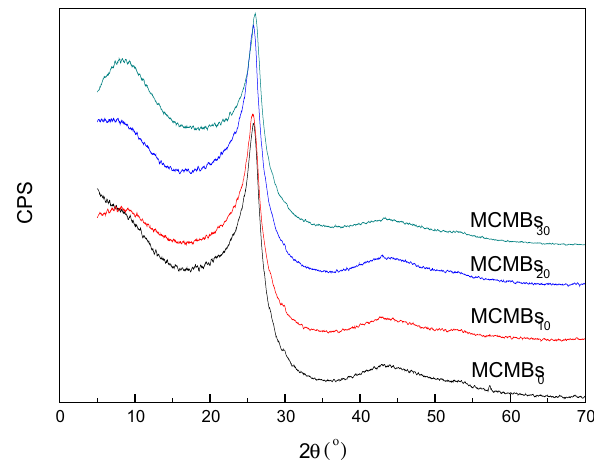
Fig. 6 XRD patterns of MCMBs with DCLR-P added